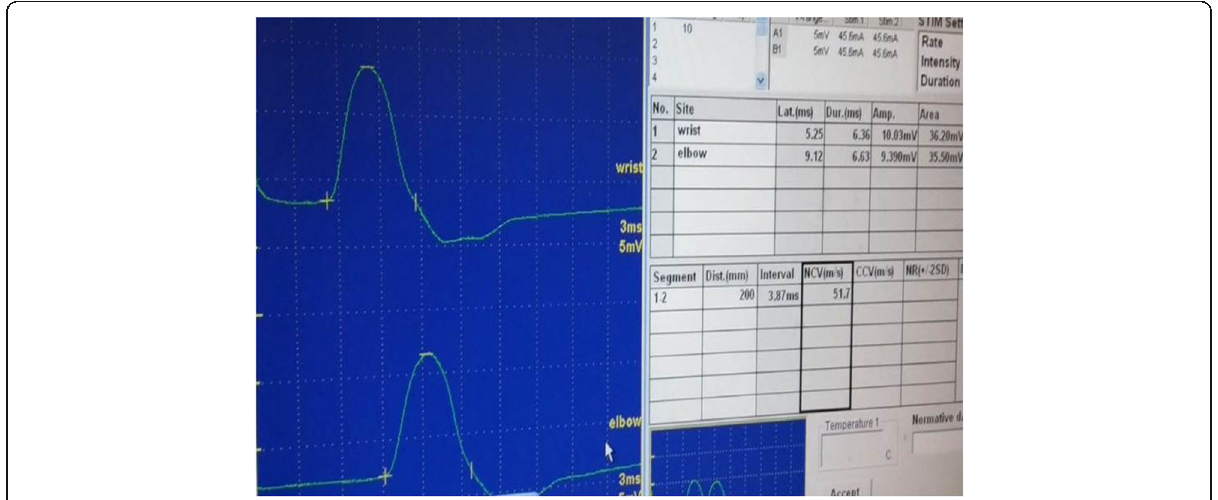
Fig. 1 MNCS of patient of the first group before injection with delayed distal motor latency, normal amplitude, and conduction